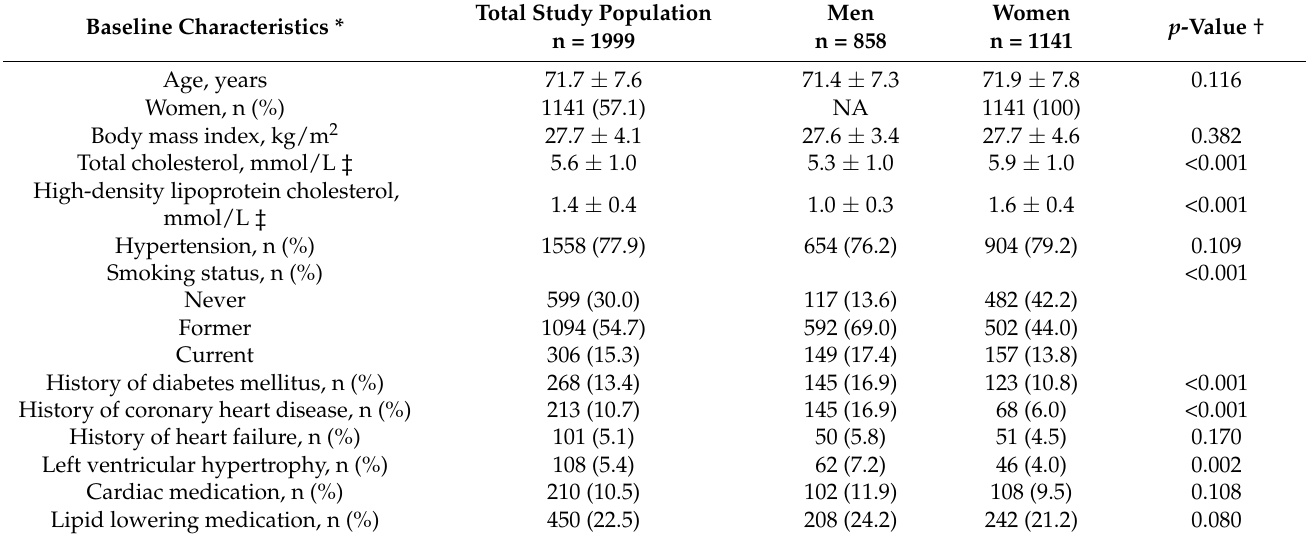
Table 1. Baseline characteristics of the total study population and stratified by